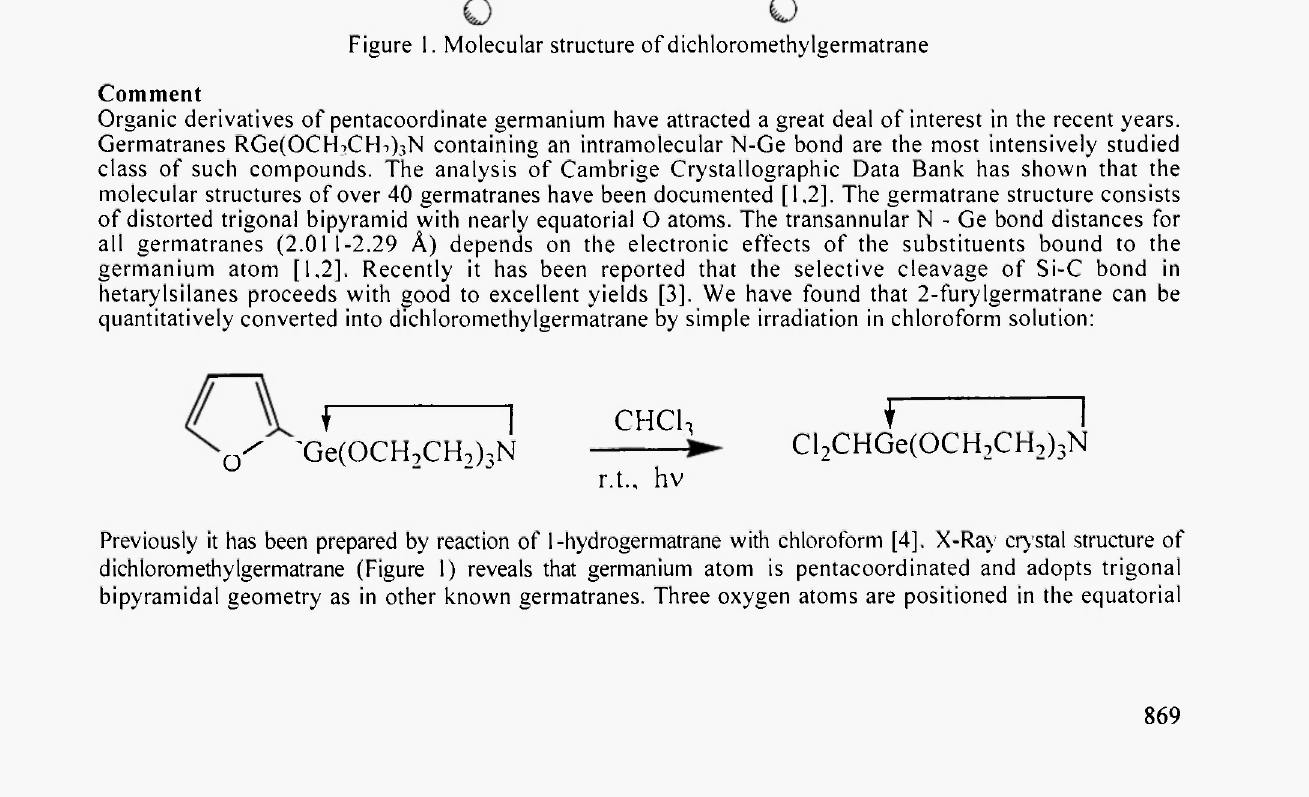
Figure 1. Molecular structure of